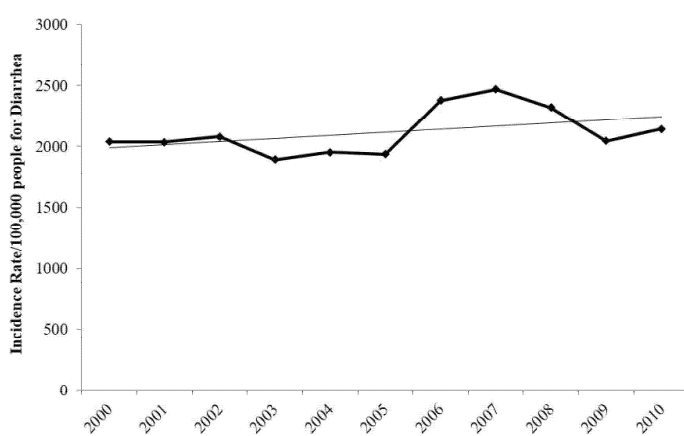
Figure 1. Incidence rate per 100,000 people for diarrhea in Jordan (2000–2010). Source: Jordanian Ministry of Health data [33].